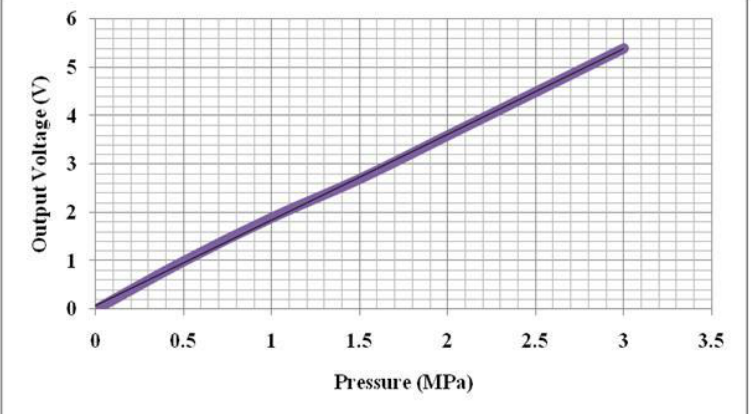
Figure 14. Graph demonstrating highly linear output voltage vs . pressure